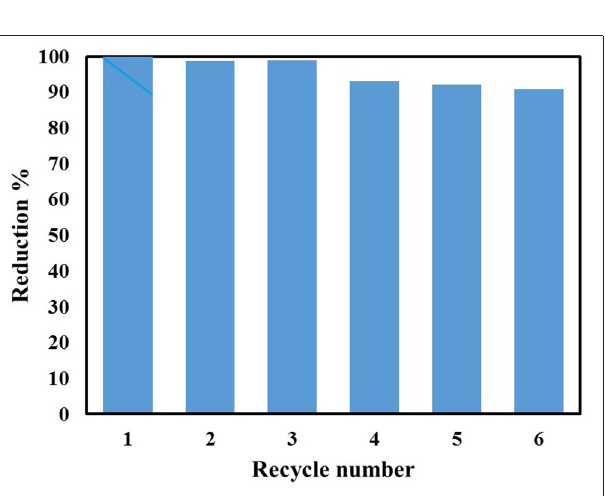
moieties on CNT-graphene, established via CV, FTIR, and Raman results. EIS results also indicated the smallest intercept for 4%Ag/CNT-graphene 400 , which integrated the electrolyte solution resistance and contact resistance at the interface of the active material/current collector. Increasing the slope of the latter comparatively provides the sample best capacitance based on the excellent ions diffusion into the interior of the composite besides the aforementioned good charge transfer and low internal